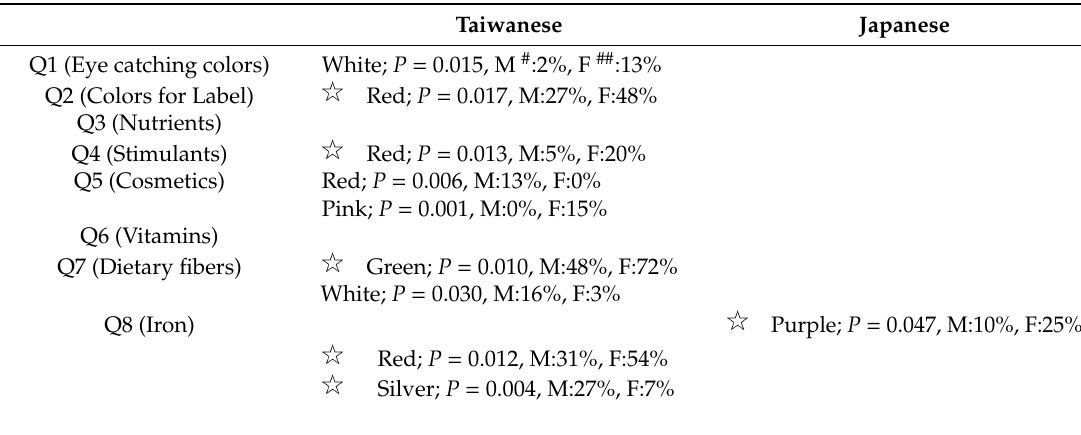
Table 3. Inter-gender comparison by Fisher (cid:48) s exact test. Taiwanese